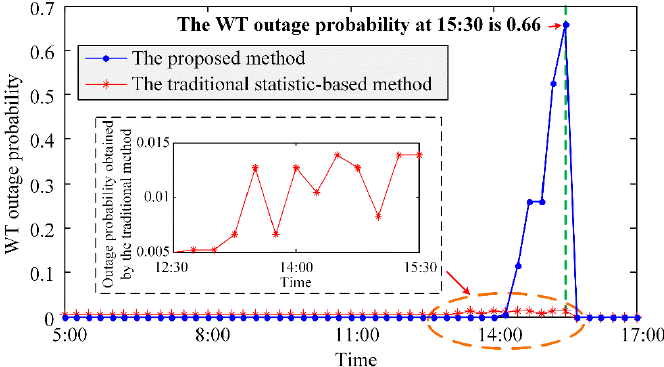
Figure 17. A comparison of WT outage probabilities obtained by the proposed method and the traditional statistic ‐ based method.